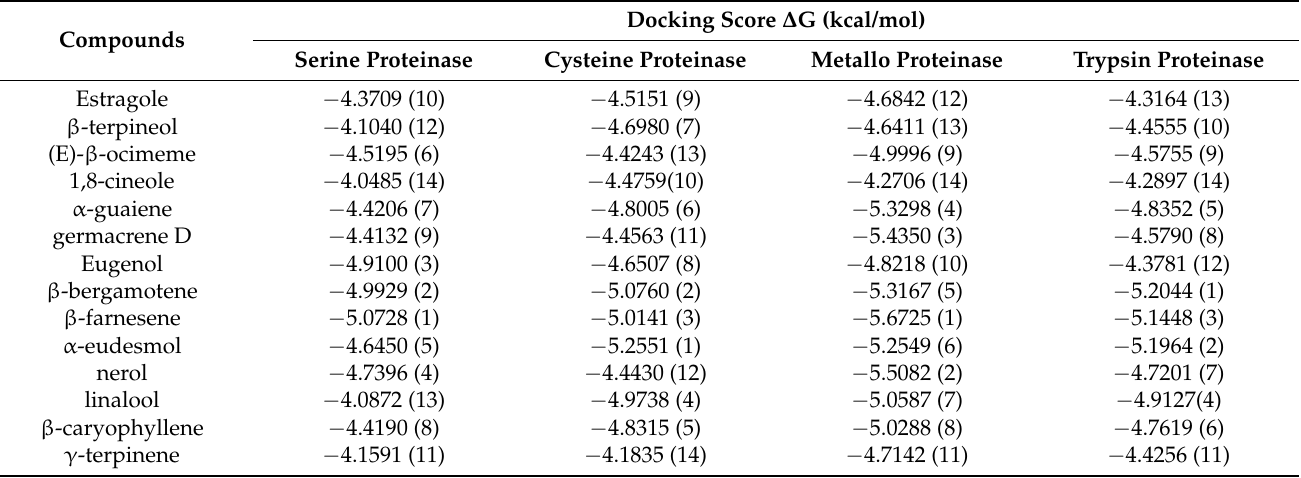
Table 3. Compounds’ docking scores within the active sites of serine proteinase (PDB:3F7O), metallo- proteinase (PDB:1KAP), trypsin proteinase (1FN8), and cysteine proteinase